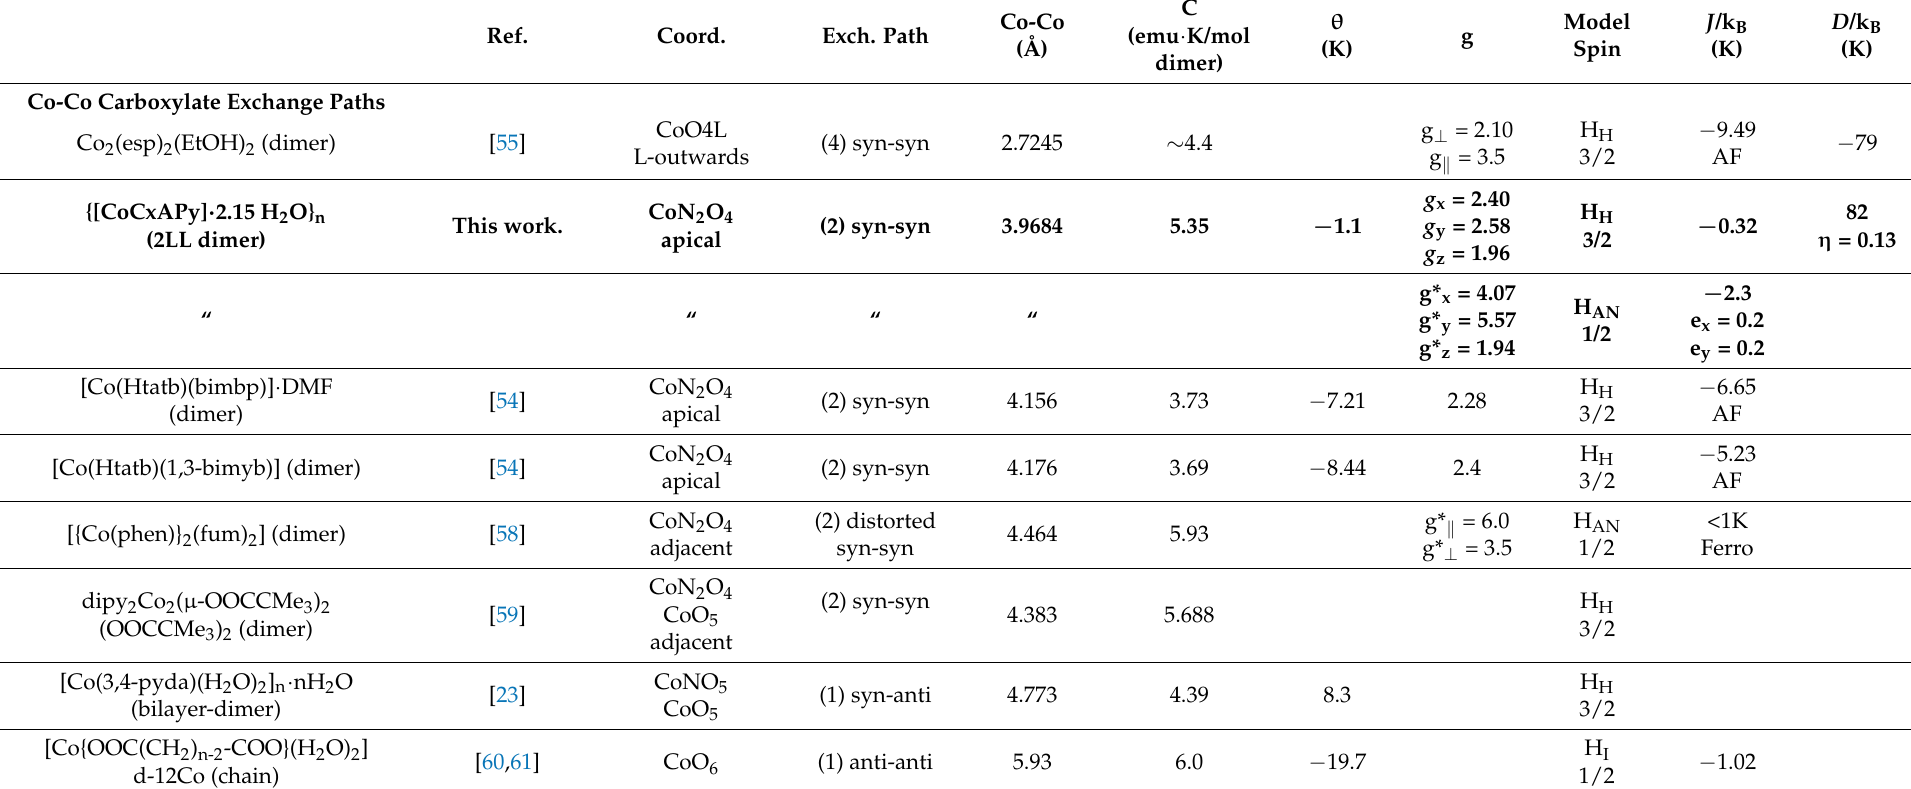
Table 4. Compounds with Co-Co exchange interaction (spatial interaction dimension). Reference. Co coordination. Exchange path: carboxylate paths (Co-O-C-O-Co) { in parenthesis (#) number of carboxylate paths, type of path}, and oxygen mediated path (Co-O-Co). Co-Co distance. C , Curie constant (for comparison purposes, the C value given in this Table assumes 2 Co per f.u; for a Co(II) dimer, C = 3.75 emu · K/mol for spin only 3/2), θ , Curie–Weiss temperature, g , gyromagnetic factor ( g * in effective spin S = 1/2 ground state), sub-indexes indicate directions ( x , y , z ), or spin subsystems. Exchange interaction Hamiltonian, transformed to the H H = − 2 J S 1 S 2 (Heisenberg), H I = − 2 JS z1 S z2 (Ising) or H AN = − 2J(S z1 S z2 + e x S x1 S x2 + e y S y1 S y2 ) (Anisotropic) conventions, Spin, S = 3/2 model, or effective spin S * = 1/2 model. J /k B , exchange interaction constant. D /k B , anisotropy